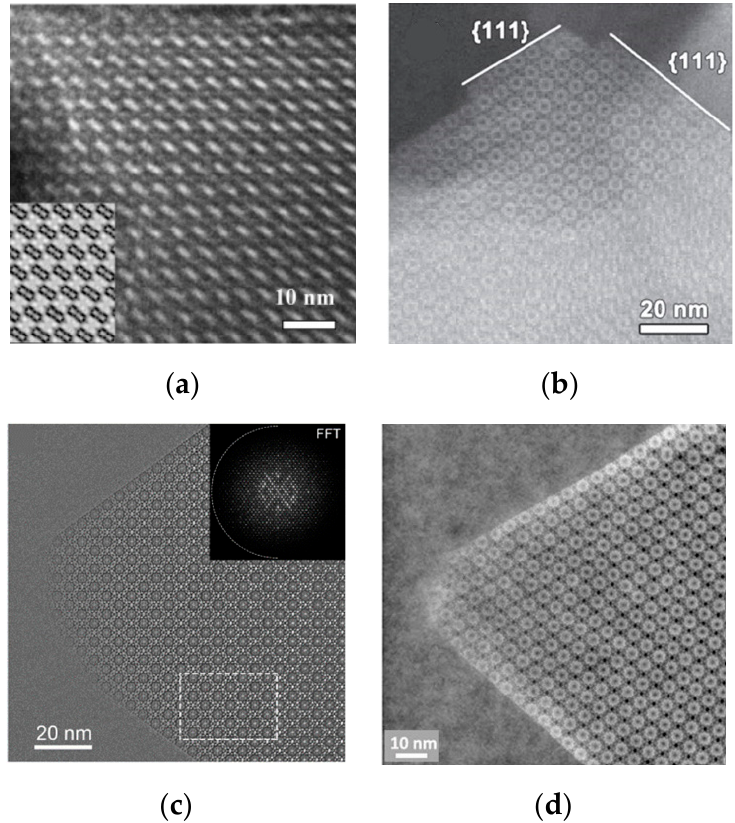
Figure 16. A series of electron microscopy images of MIL-101 acquired in different years: ( a ) HRTEM image in 2005. Reprinted/adapted with permission from Ref. [112]. Copyright 2005, American Chemical Society. ( b ) ADF-STEM image in 2016. Reprinted/adapted with permission from Ref. [113]. Copyright 2016, John Wiley and Sons. ( c ) low-dose HRTEM image (with DDEC) in 2019.(FFT for the white box) Reprinted/adapted with permission from Ref. [114]. Copyright 2019, American Chemical Society. ( d ) iDPC-STEM image in 2020. Reprinted/adapted with permission from Ref. [115]. Copyright 2020, Springer Nature.